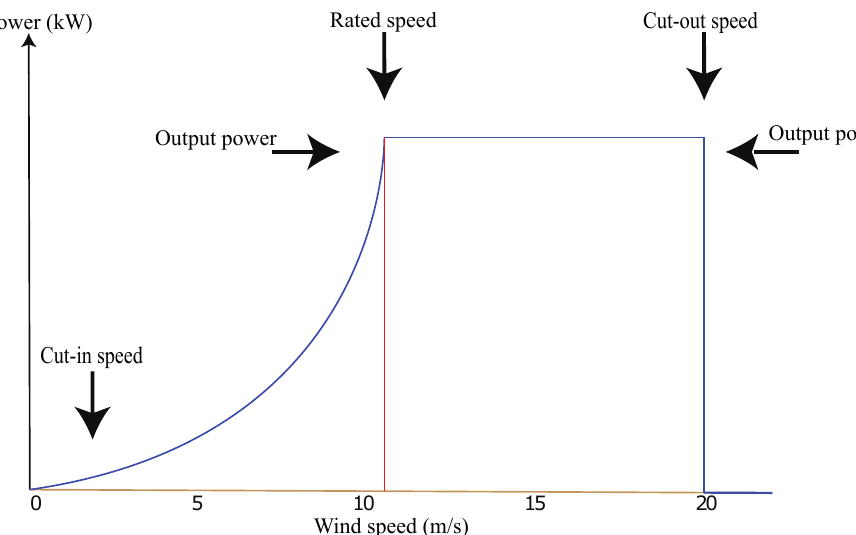
Figure 3. WT electricity generation with rated, cut-in, and cut-out speed.